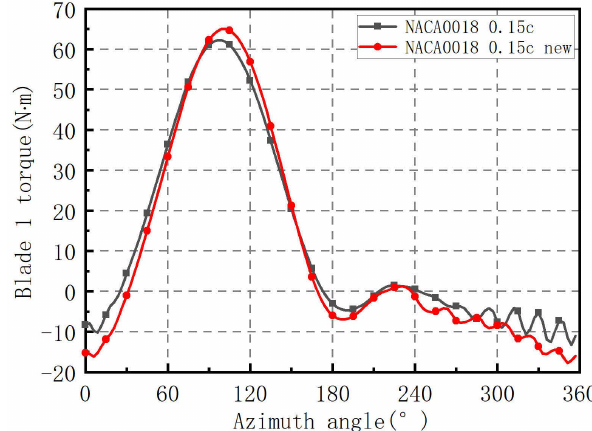
Figure 32. Torque of J-blade wind generator before and after optimization (TSR =